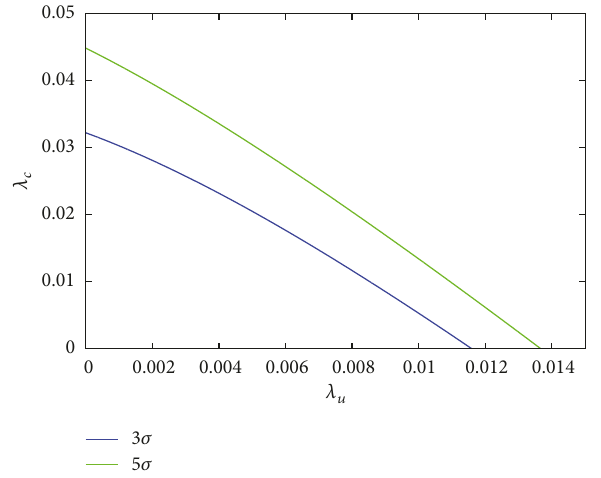
Figure 11: The contour plot for the couplings 𝜆 𝑢 and 𝜆 𝑐 at LHeC for an integrated luminosity of 500 fb −1